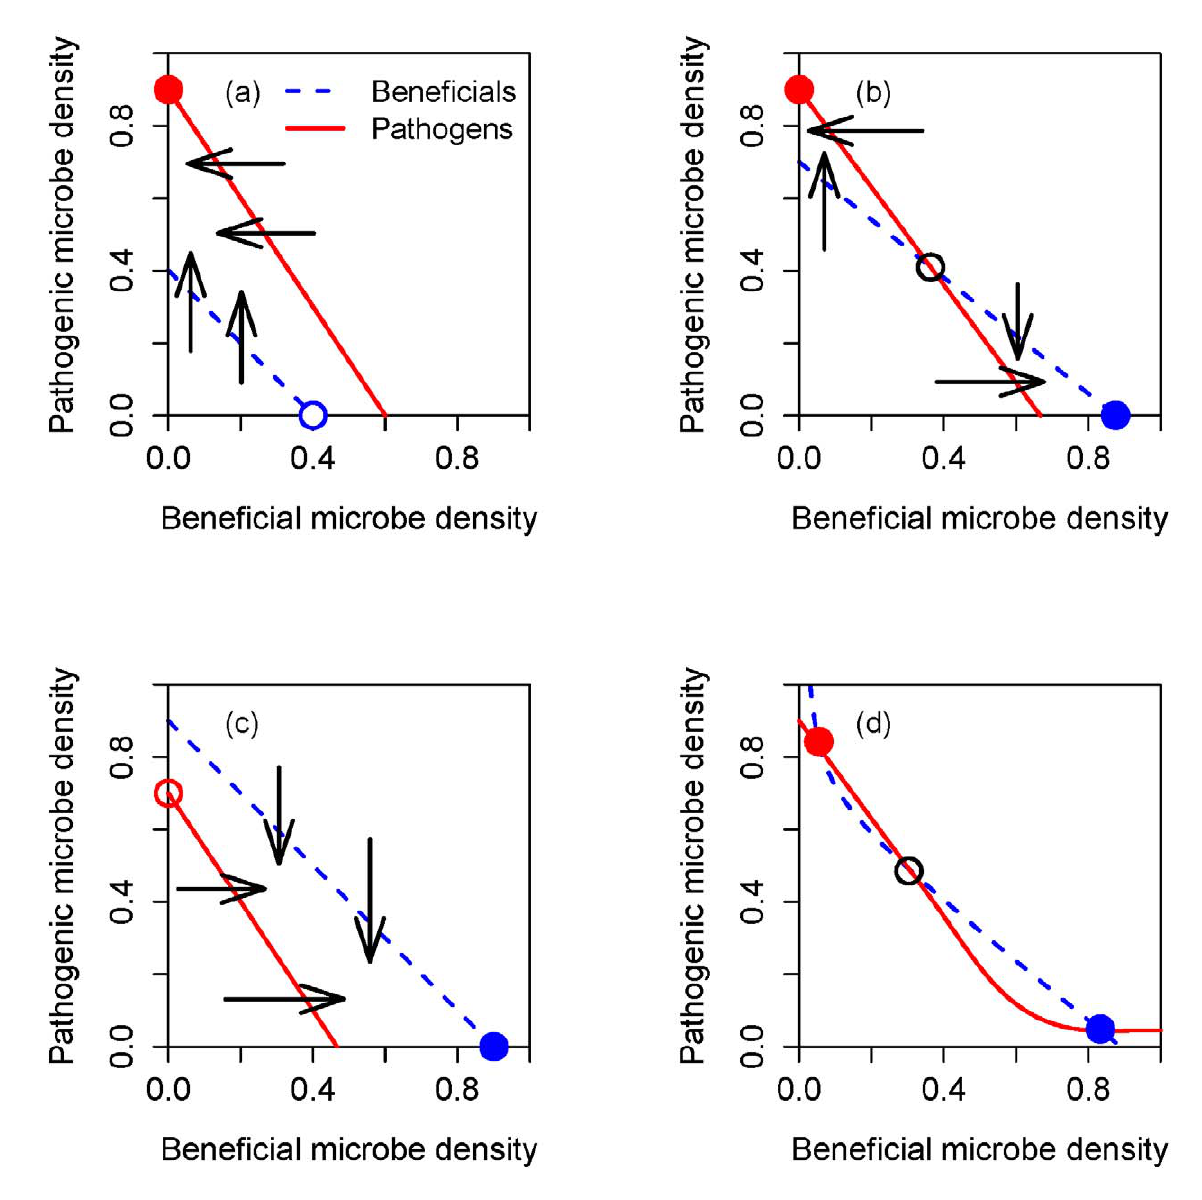
Figure 1. Nullcline analysis of the general well-mixed SMC model. Stable equilibria are shown as filled circles and unstable equilibria as open circles. Arrows indicate the direction of population change on the nullclines. (A) The P nullcline (solid red line) lies above the B nullcline (blue dashed line), leading to exclusion of beneficials. (B) Because the P nullcline is steeper than the B nullcline, if the nullclines cross their intersection (open circle) is a saddle and therefore unstable. The stable manifold of the saddle divides the interior of the quadrant into the sets of initial points leading to competitive dominance by one type of microbe and competitive exclusion of the other. (C) The B nullcline lies above the P nullcline, leading to exclusion of pathogens. (D) Small rates of microbial immigration are permitted, with the qualitative effect of preventing complete extinction when interactions within the mucus layer would otherwise lead to competitive exclusion.